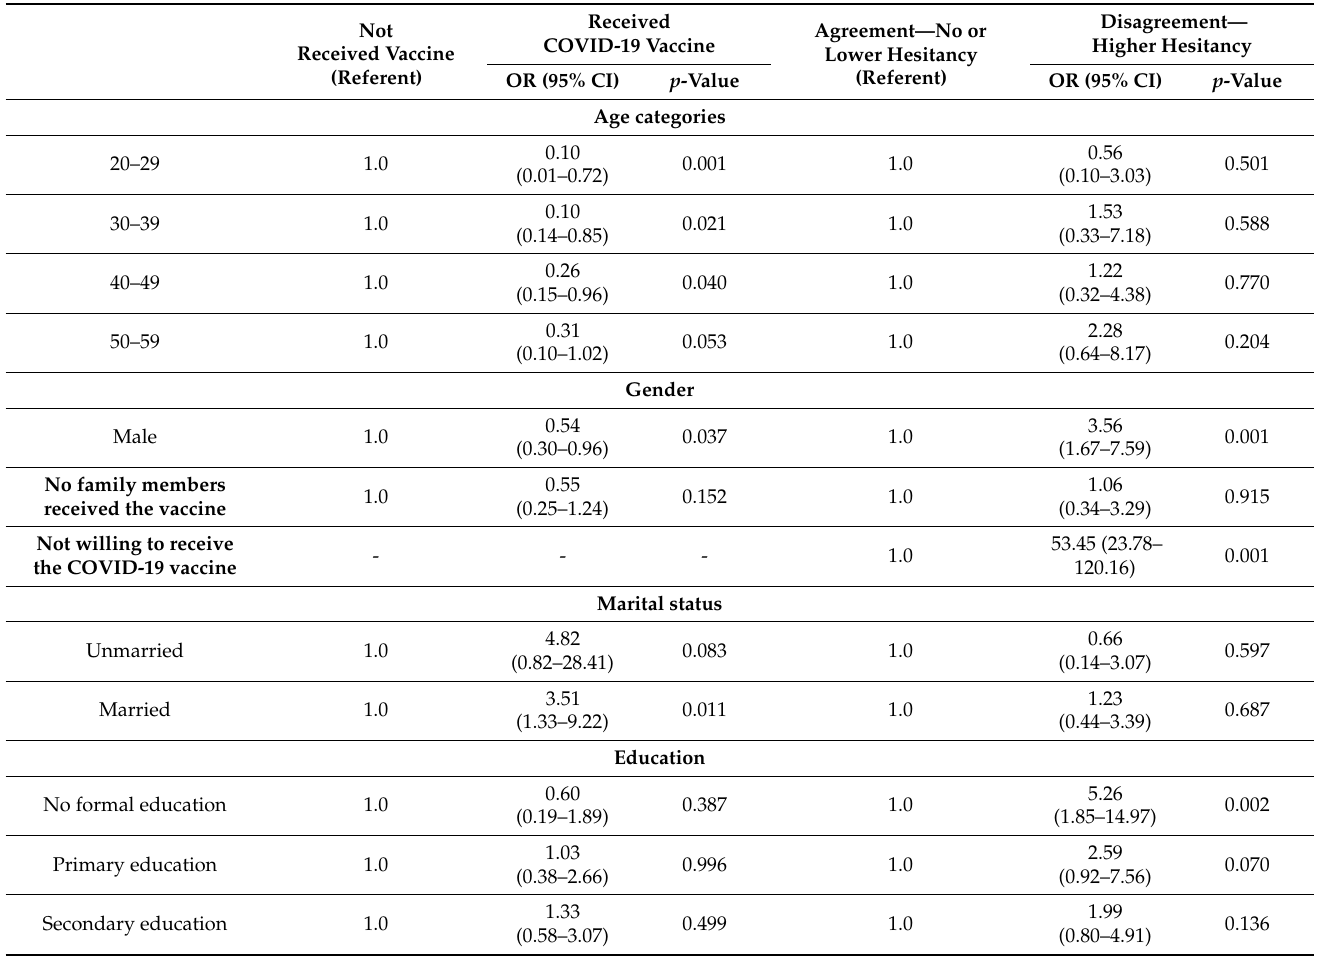
Table 5. Multivariate logistic regression examining the association of patient-related factors with vaccine acceptance and